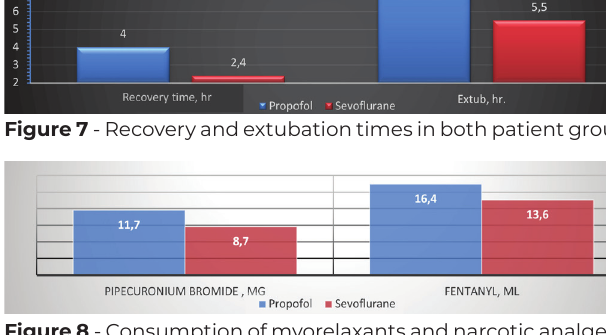
Figure 8 - Consumption of myorelaxants and narcotic analgesics in both patient groups. The recovery time and extubation time were significantly different between the groups (Figure 7). Recovery time was equal to 4.0±1.3 hours in TIVA group and to 2.4±0.8 hours in